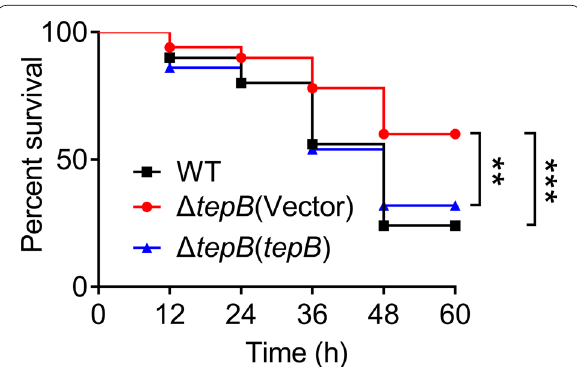
Fig. 6 TepB is involved in virulence toward C. elegans . C. elegans were infected with P. aeruginosa PA14 wild-type, Δ tepB mutant and the complemented Δ tepB ( tepB ) strains. The survival rate of C. elegans after infection by P. aeruginosa PA14 was shown in 48 h. Data represent the mean of three biological replicates, each of which was performed with three technical replicates. Statistical analysis was performed by Log-Rank test. ** P < 0.002; *** P <